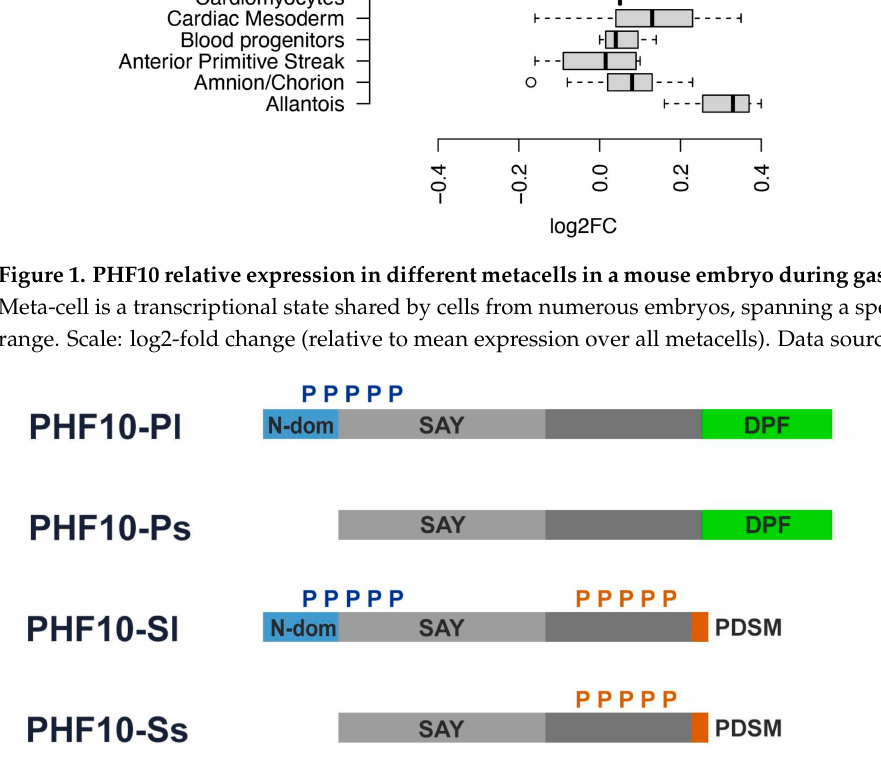
Figure 2. PHF10 isoforms: blue boxes represent 46 amino acids at N-terminus of the long isoforms of PHF10 isoforms; green boxes represent DPF domains; light grey boxes represent SAY domains; orange boxes represent PDSM (phosphorylation-dependent sumoylation motif); blue “P” and orange “P” denote multiple N-terminal phosphorylation and multiple X-cluster phosphorylation,